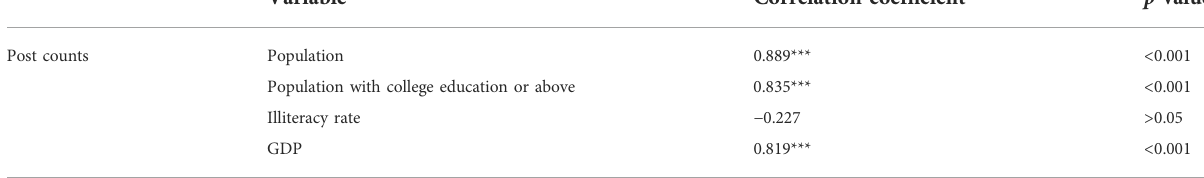
TABLE 3 The results of correlation analysis at the provincial level (N =